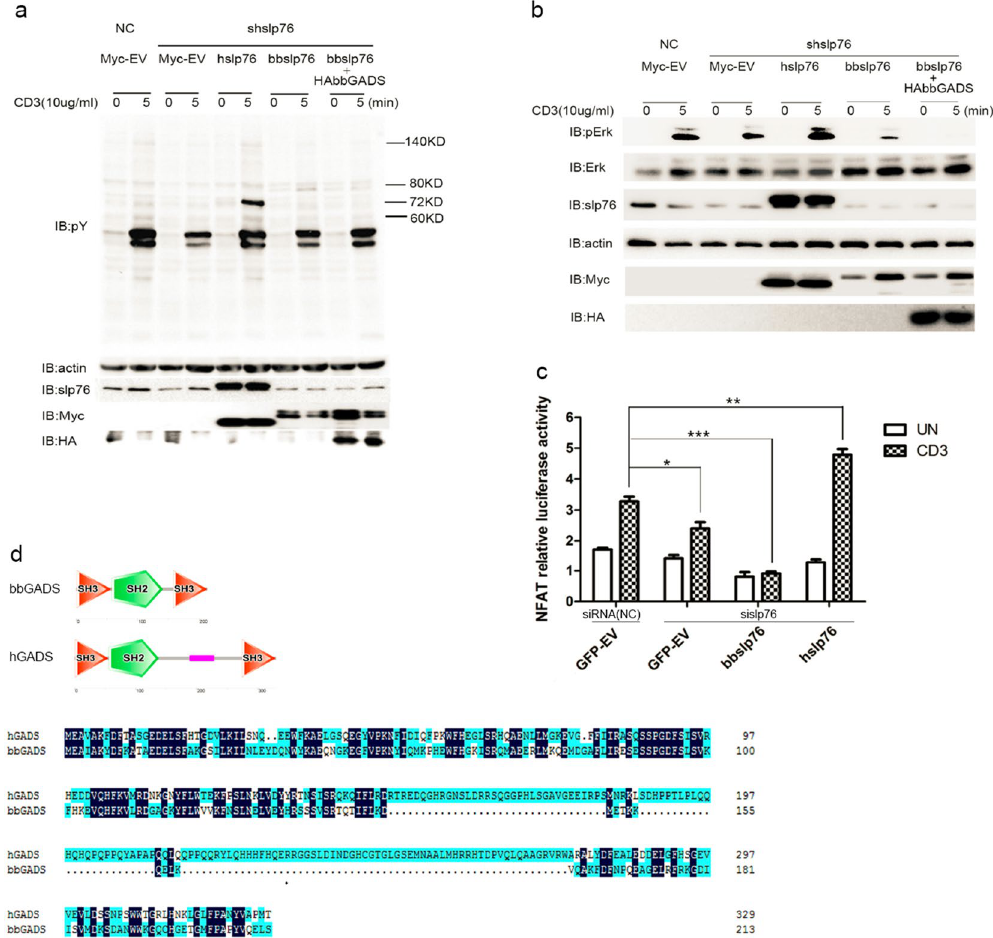
Figure 3. bbslp76 inhibits TCR-induced NFAT activation. ( a ) bbslp76 inhibits the total tyrosine phosphorylation of Jurkat TAg cells after TCR ligation. Jurkat TAg cells were transfected with NC (negative control, scrambled small interfering RNA) and shslp76 (short hairpin RNA targeting hslp76 RNA specifically). shslp76-transfected cells were separately co-transfected with Myc-hslp76, Myc-bbslp76, and Myc-bbslp76 plus HA-bbGADS. After 48 hrs, cells stimulated with or without CD3 (10 μ g/mL, 5 min) were subjected to western- blotting to analyze the tyrosine phosphorylation (pY) of T cells. ( b ) bbslp76 inhibits the phosphorylation of Erk (pErk) in Jurkat TAg cells after TCR ligation. Cells and lysates were prepared as in ( a ). ( c ) bbslp76 inhibits NFAT activity in T cells. Jurkat TAg cells were transfected with NC and sislp76 (small interfering RNA targeting hslp76 RNA specifically). NC and sislp76 cells were transfected with an NFAT reporter construct and a co-transfected Renilla luciferase and the indicated constructs. 48 hrs later, cells were untreated or stimulated with CD3 (3 μ g/ mL) for 8 hrs and lysed for the reporter gene assay. Luciferase activity was normalized using a co-transfected Renilla luciferase. The data represent the mean ± SD from triplicate determinations. * P < 0.05, ** P < 0.005, *** P < 0.0005. ( d ) Protein structure of bbGADS and hGADS generated by SMART. And sequences alignment of bbGADS and hGADS. The color of Sky blue represents 50% consensus of amino acid and dark blue represents 100% consensus of amino acid. The experiments were repeated three times with very similar